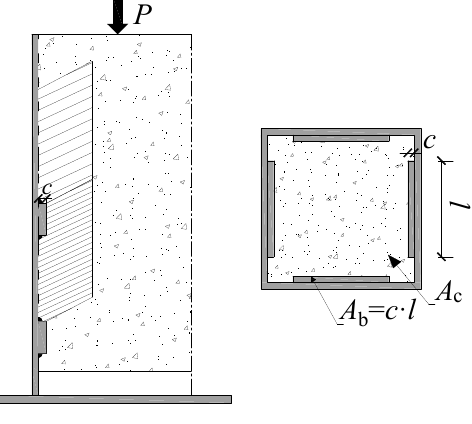
Figure 10. Stress state of shear connector.